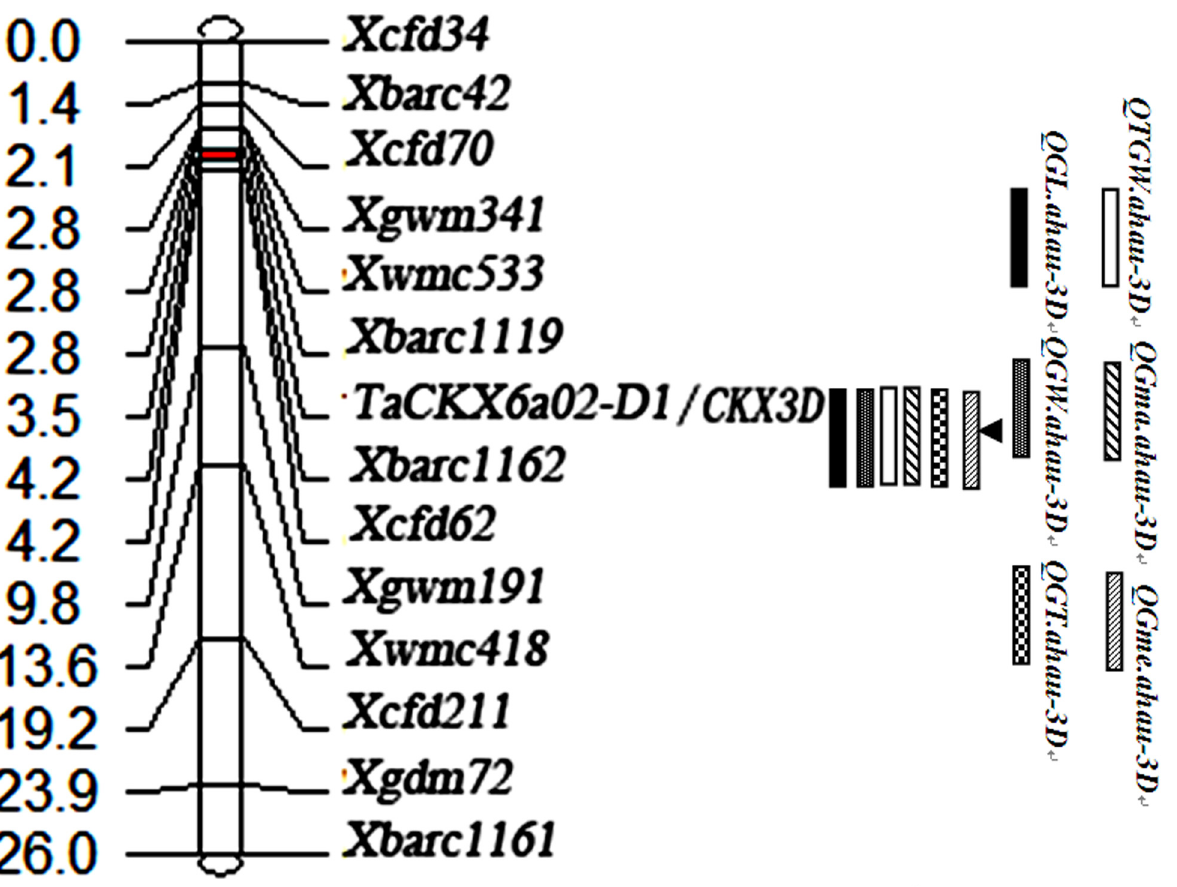
Fig 2. Linkage map of TaCKX6a02 on chromosome 3DS of wheat. The six shaded boxes represent the six traits of TGW, GW, GL, GT, GFRmax, and GFRmean, respectively.